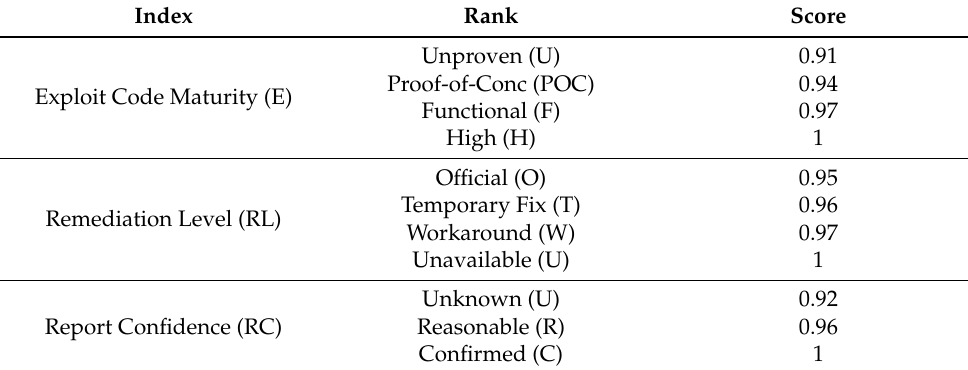
Table 2. CVSS Score (temporal